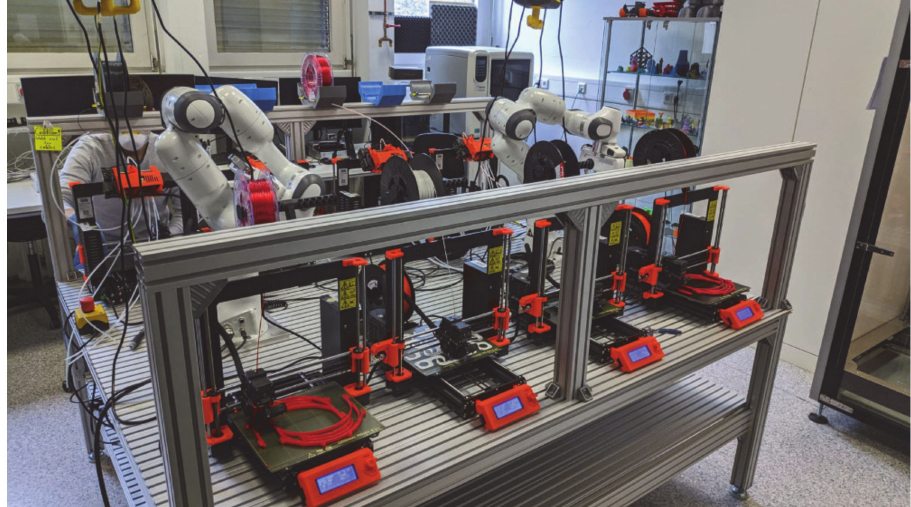
Figure 2. The 3D-printing setup at the Karlsruhe Institute of Technology (KIT) Institute for Automation and Applied